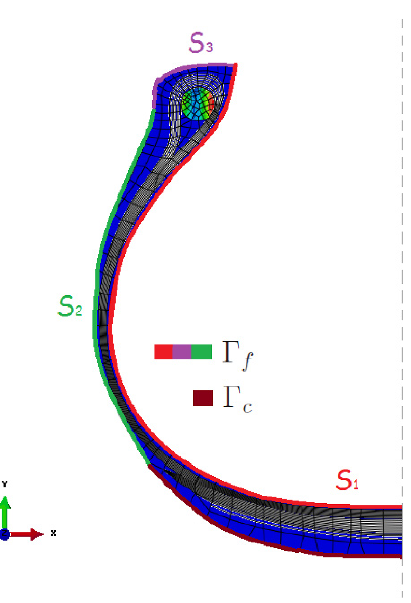
Figure 4. Thermal boundary conditions.